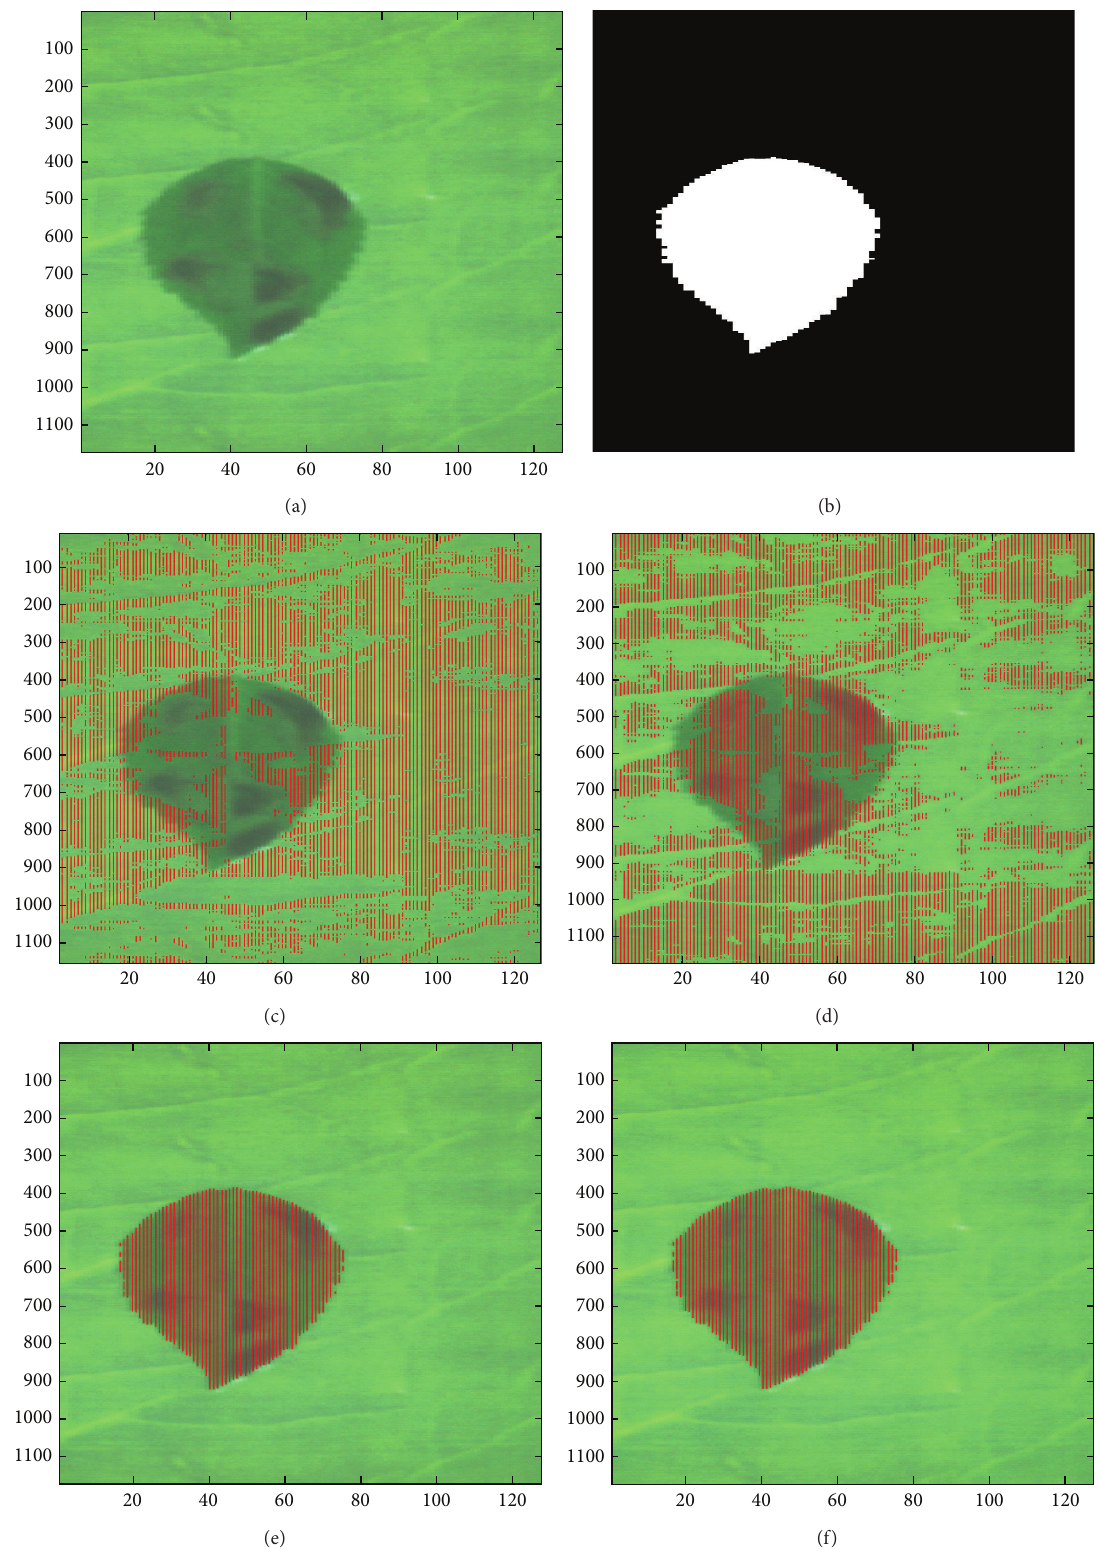
Figure 7: Abnormal region detection results: (a) test leaf image, (b) ground truth, (c) PCA method, (d) spectral profile, (e) Proposed 1 band selection by spectral analysis, and (f) Proposed 2 band selection by spectral-spatial